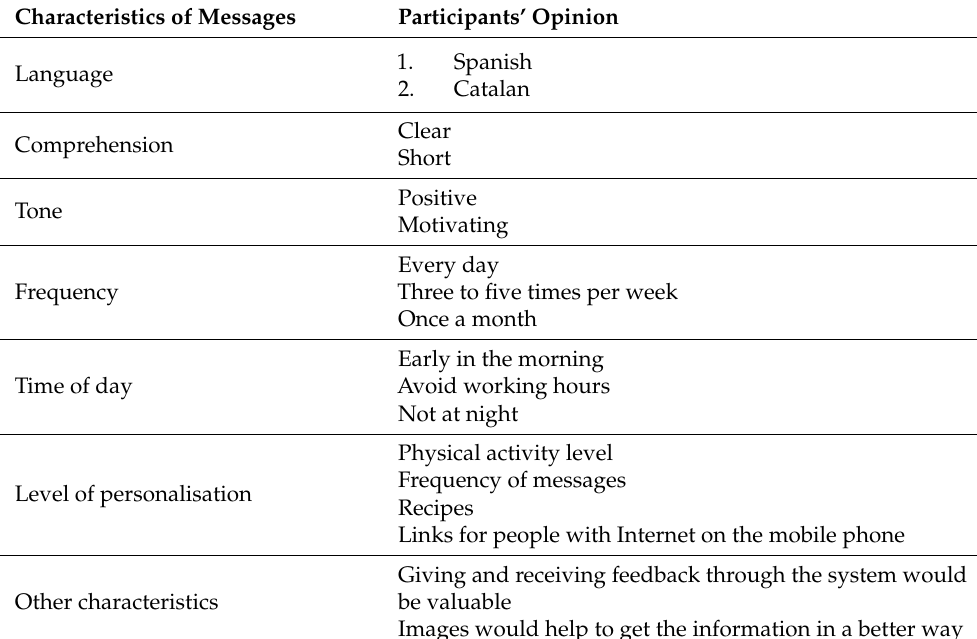
Table 3. Characteristics of the messages that were suggested by participants from four focus groups with people with type 2 diabetes in the Balearic Islands (Spain) during October 2019 and January 2020. Characteristics of